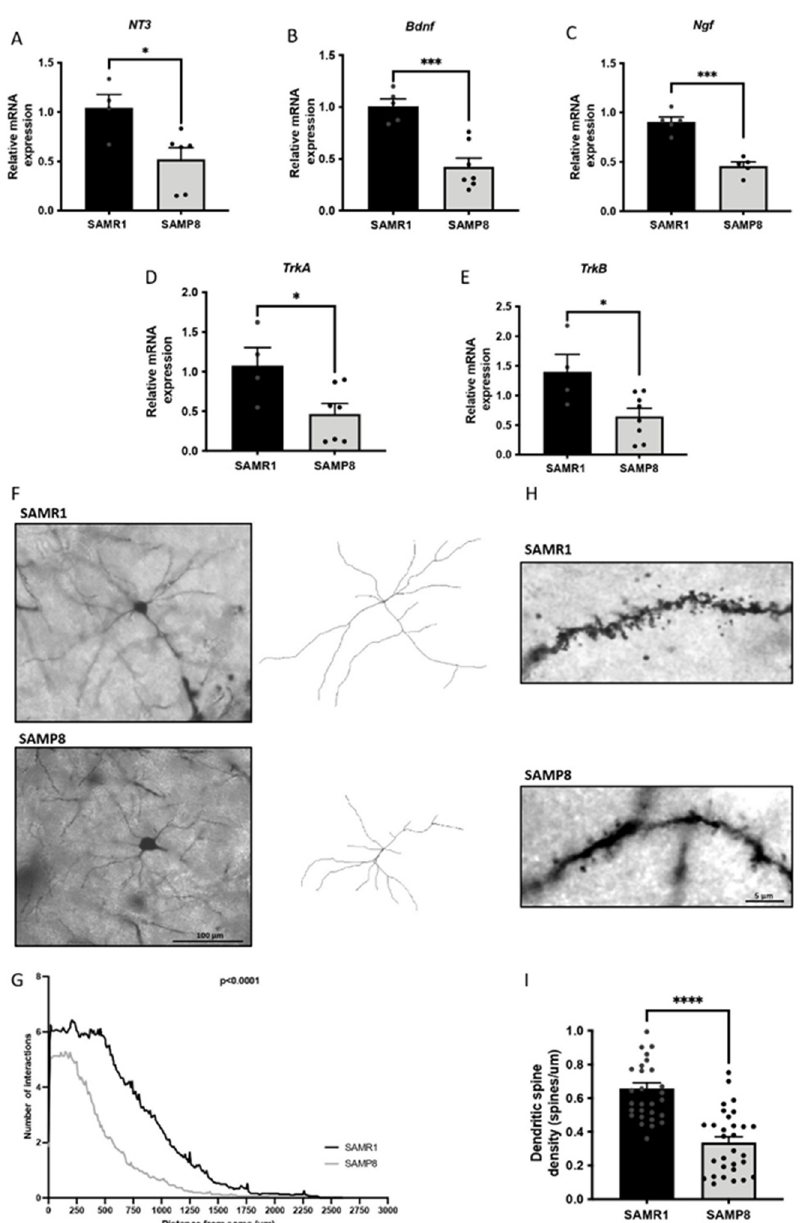
Figure 6. Representative gene expressions for NT3 ( A ), Bdnf ( B ), Ngf ( C ), TrkA ( D ) and TrkB ( E ). The gene expression levels were determined by real-time PCR. Bars show the mean ± SEM (n = 4–8 mice per group). Statistical test: t-Student analysis. * p < 0.05; *** p < 0.001. Representative images and tracings of Golgi-stained cortical neurons from the aged SAMR1 male mice group (top) and the age SAMP8 male mice group (bottom) (scale bar = 100 µm) ( F ). Aged SAMP8 male mice showed a reduction in the number of neuronal intersections compared with the SAMR1 control group through a Sholl analysis ( G ). Representative images of the spine density of the aged SAMR1 male mice group (top) and the aged SAMP8 male mice group (bottom) by Golgi staining ( H ) and quantification ( I ). Bars show the mean ± SEM (n= 28–30 neurons from 6 different mice per group). Statistical test: t-Student analysis. **** p < 0.0001.